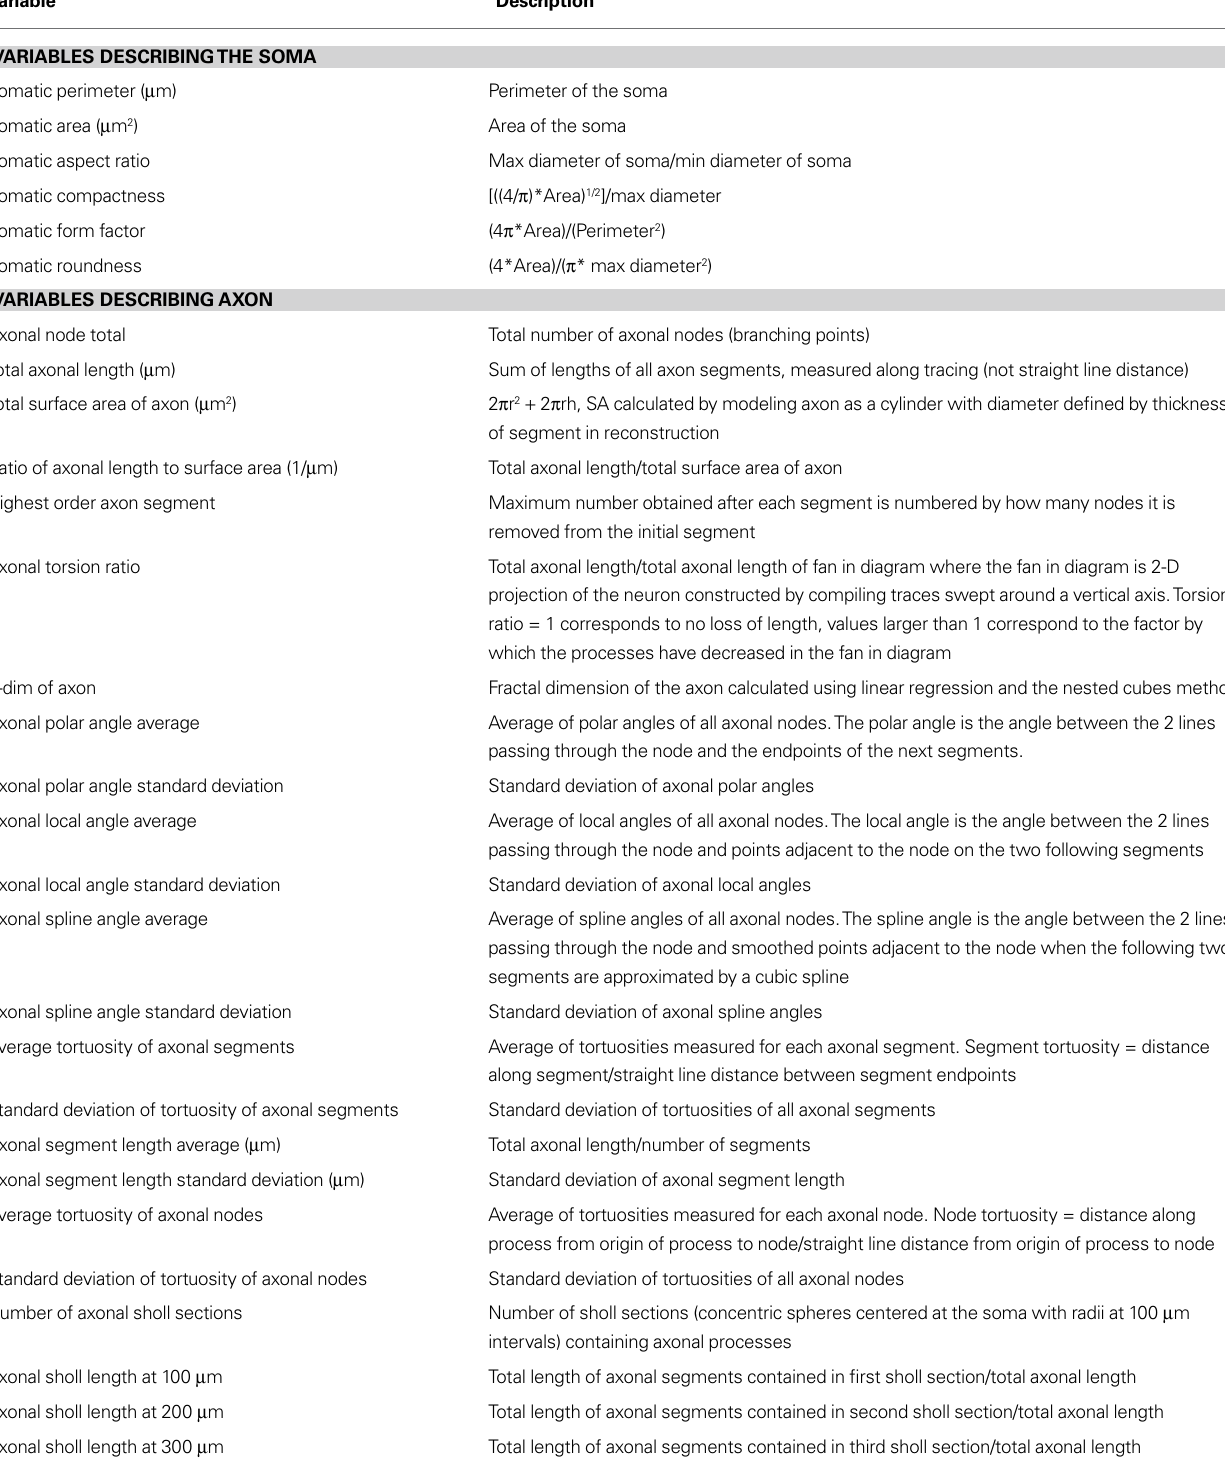
Table 2 | Morphological variables. Variables were extracted using the Neurolucida Explorer program by